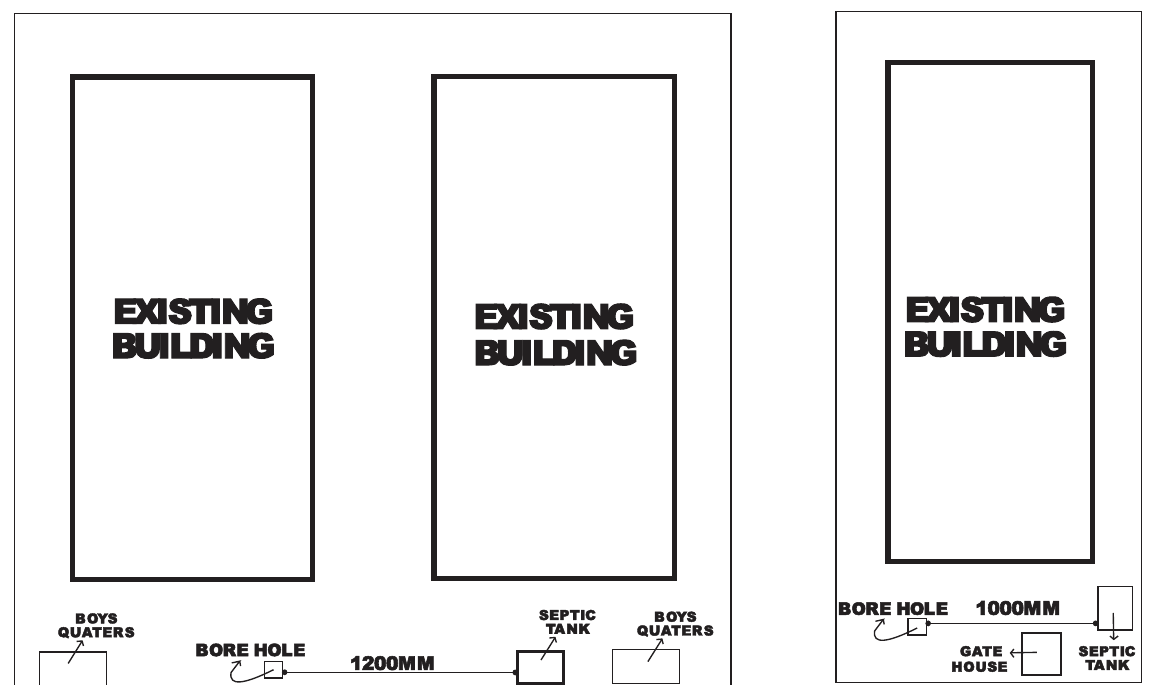
Fig. 6. Borehole distance to Septic tank and Soakaway pit in a selected